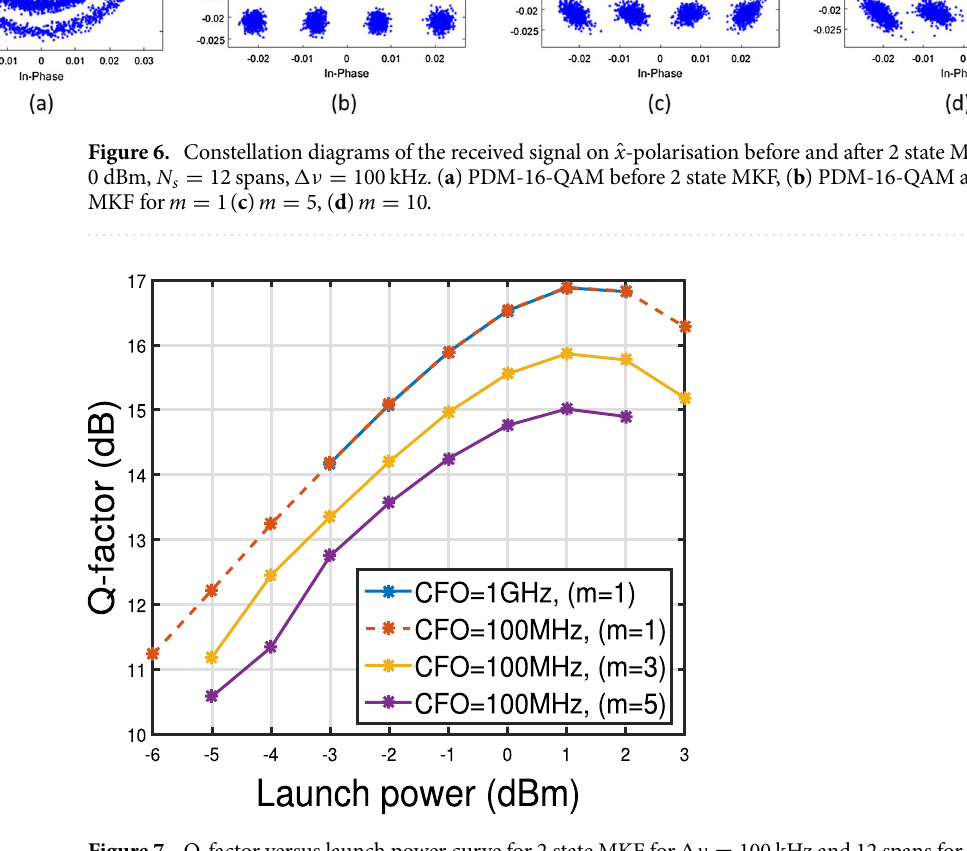
Figure 7. Q-factor versus launch power curve for 2 state MKF for �ν CFO values and step sizes ( m